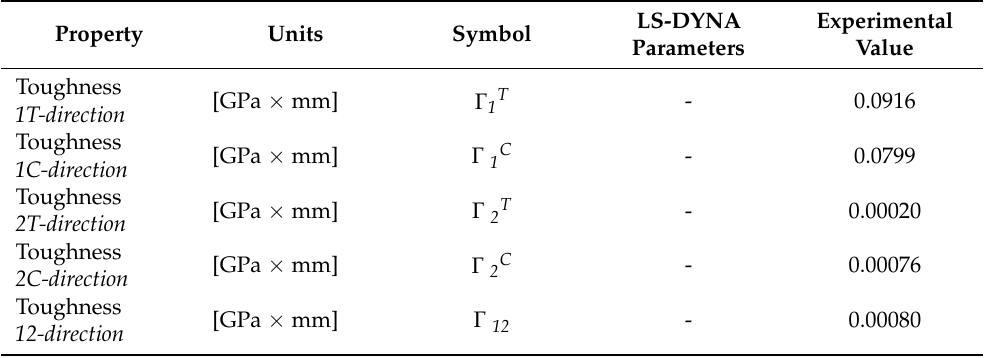
Table 2. Associated intralaminar toughness of IM7/8552 as published in [38] and relative nomencla- ture for